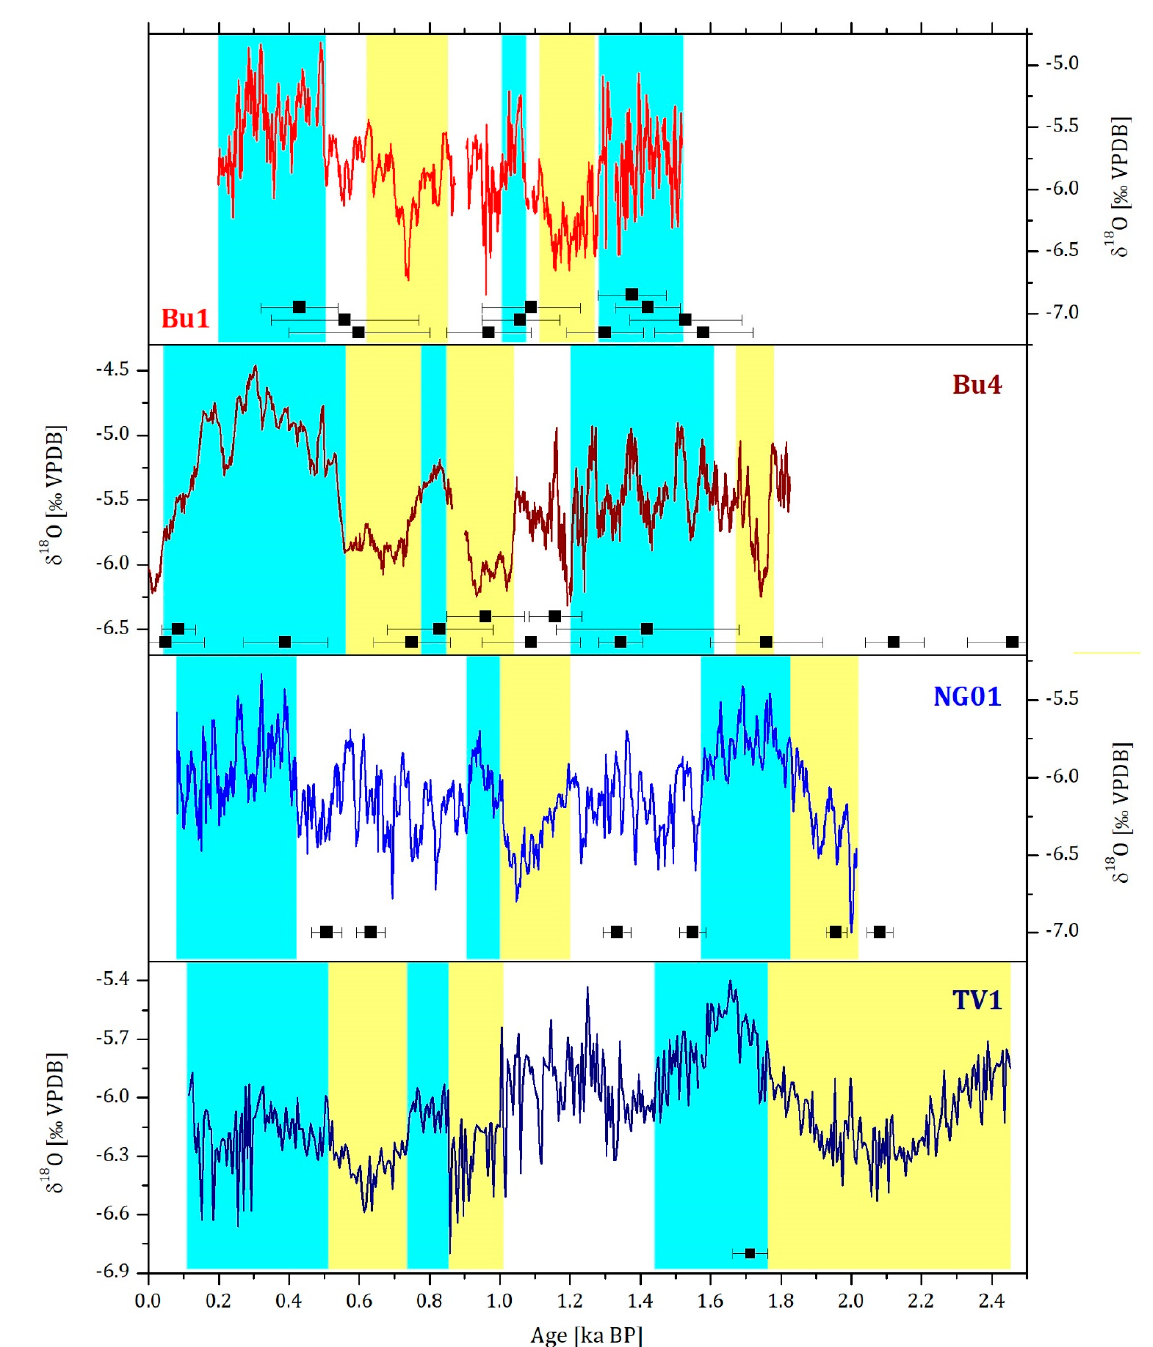
Figure 3. Stable isotope records of all four speleothems (Bu1, Bu4, NG01 and TV1) for the last 2.5 ka BP. Blue bars indicate phases of higher δ 18 O values and yellow bars phases of lower δ 18 O values. 230 Th/U ages are indicated in the lower part of each panel.